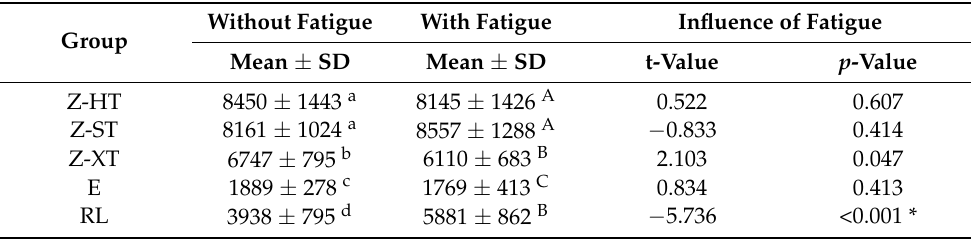
Table 3. Descriptive statistics of failure load (in N). Statistically significant differences ( p < 0.05) are indicated by different superscript letters within a column without (small letter) and with (capital letter) fatigue exposure. t - and p -values of t- tests for influence of fatigue by pairwise material comparison (within a row) (* indicates significance after Bonferroni correction: p < 0.01).